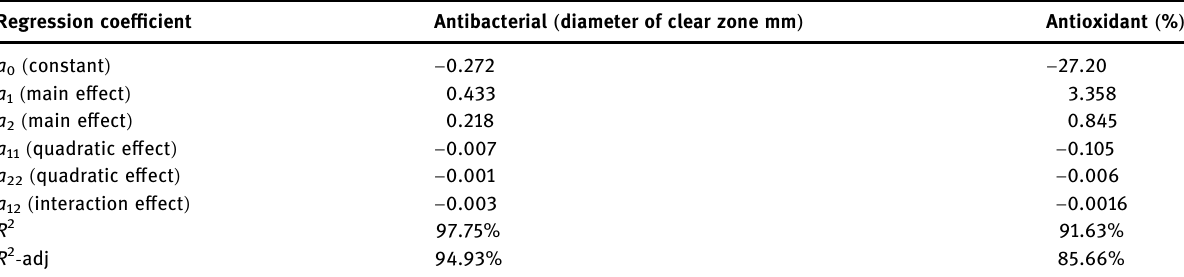
Table 3: Regression coe ffi cients, R 2 , R 2 - adj, and probability values for the fi tted models Regression coe ffi cient